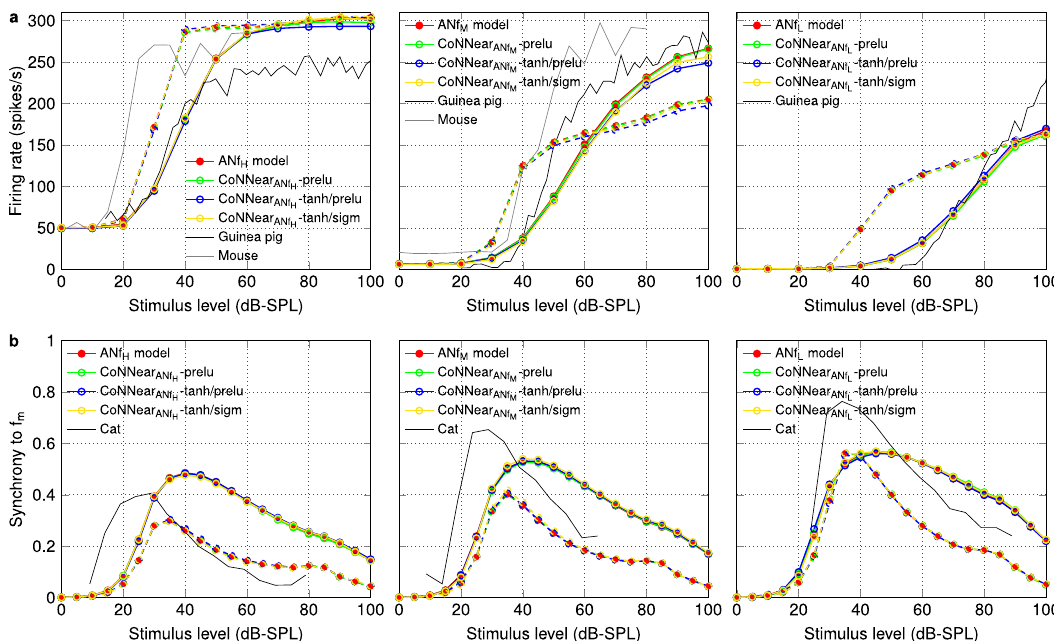
Fig. 6 Level-dependent properties of the different ANF models. a From left to right, ANF rate-level curves (Metric 5) were simulated for the HSR, MSR, and LSR ANF models, respectively, at CFs of 1 (dashed lines) and 4 kHz (solid lines). The reference data stemmed from guinea pig ( fi bers with SRs of 65, 10, and 0 spikes/s at a CF of ~1.5 kHz; Fig. 1 in ref. 48 ) and mouse recordings (CF of 18.8 kHz for SR of 47.6 spikes/s and CF of 23.7 kHz for SR of 0.1 spikes/s; Fig. 6 in ref. 64 ). b From left to right, ANF synchrony-level functions (Metric 6) were calculated for the HSR, MSR, and LSR ANF models. For each ANF model, 1 kHz and 4 kHz pure-tone carriers were modulated by an f m = 100 Hz pure tone and presented at CFs of 1 (dashed) and 4 kHz (solid). For each CF, vector strength to the f m is reported against the stimulus intensity for the three fi ber types. The reference data came from cat ANF recordings ( fi bers of 8.1 kHz CF and 2.6 spikes/s, 1.14 kHz CF and 6.3 spikes/s, and 2.83 kHz and 73 spikes/s, respectively; Figs. 5 and 8 in ref. 51